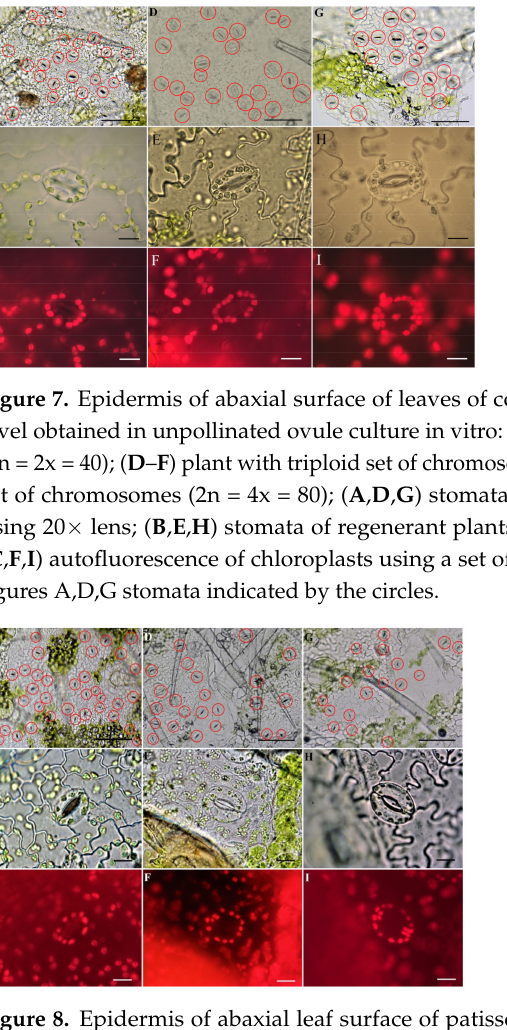
Figure 8. Epidermis of abaxial leaf surface of patisson regenerant plants of different ploidy level obtained in unpollinated ovule culture in vitro: ( A – C ) plant with diploid chromosomes; ( D – F ) plant with triploid chromosomes; ( G – I ) plant with tetraploid chromosomes; ( A , D , G ) stomata in regenerant plants of different ploidy level using 20 × lens; ( B , E , H ) stomata of regenerant plants of different ploidy levels using a 100 × lens; ( C , F , I ) autofluorescence of chloroplasts using a set of fluorescence filters using a 100 × lens. In the figures A,D,G stomata indicated by the